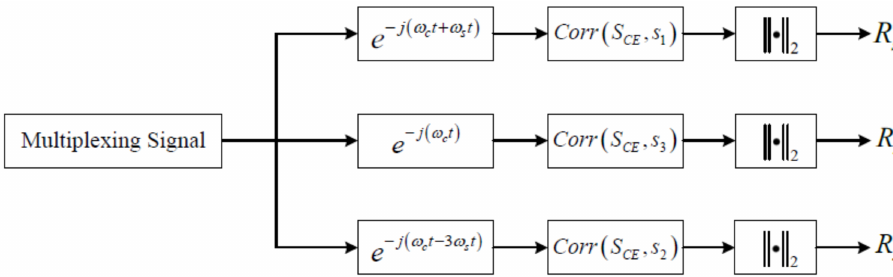
Figure 6. The receive module of the constant envelope multiplexing signal in Section